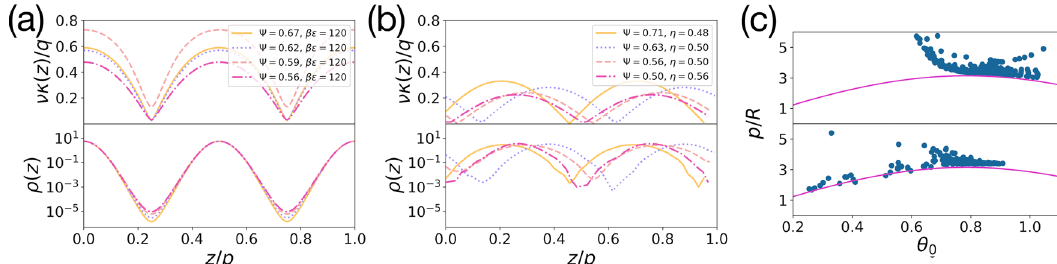
Fig. 6 Rationalization of the spatial modulations of the density and the nematic director fi elds. a – b Modulations of the curvature κ ( z ) of the integral curves of the nematic director fi eld (top), and of the logarithm of the density pro fi le ρ ( z ) (bottom) corresponding to minus the effective potential acting on the particles, in splay-bend smectic states (Sm SB ) predicted by our theory ( a ) and found in Monte Carlo simulations ( b ) for a system of hard curved spherocylinders of various curvatures Ψ and inverse temperatures βϵ or packing fractions η as labelled. c Pitch length p versus the conical angle θ 0 of various twist-bend nematic (N TB ) phases of hard curved spherocylinders of various curvatures Ψ ∈ [0.5, 2] from theory (top) and simulations (bottom), along with the relationship of Eq. (7) (pink line). Source data are provided as a Source Data